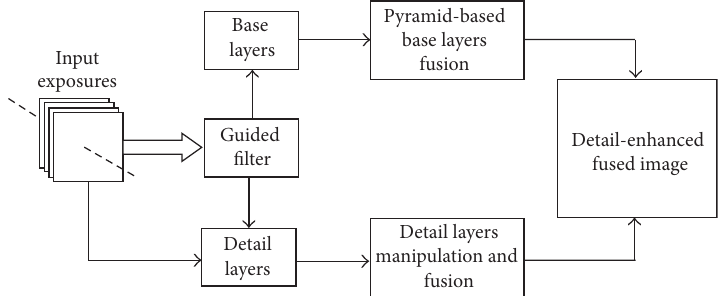
Figure 2: Proposed detail-enhanced exposure fusion